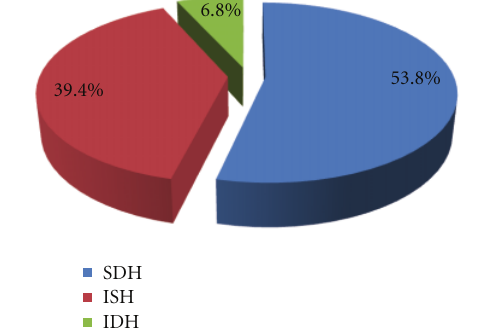
Figure 2: Definition of hypertension among the subjects using SBP or DBP or both.